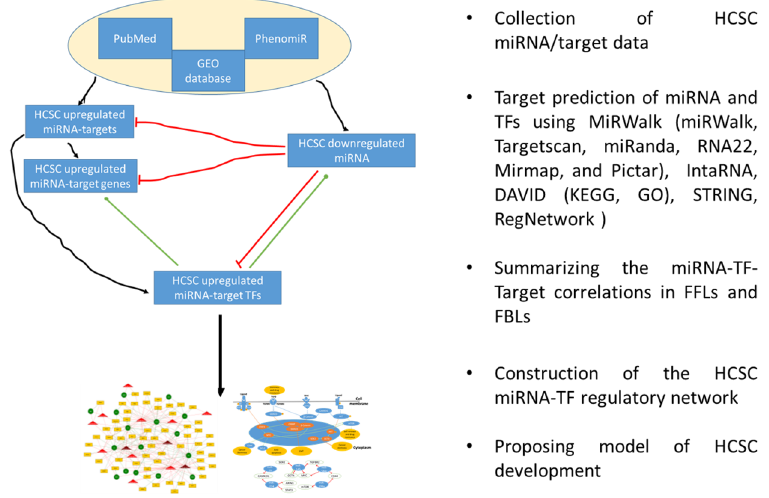
Figure 6. The flow chart illustrating the construction of the HCSC co-regulatory